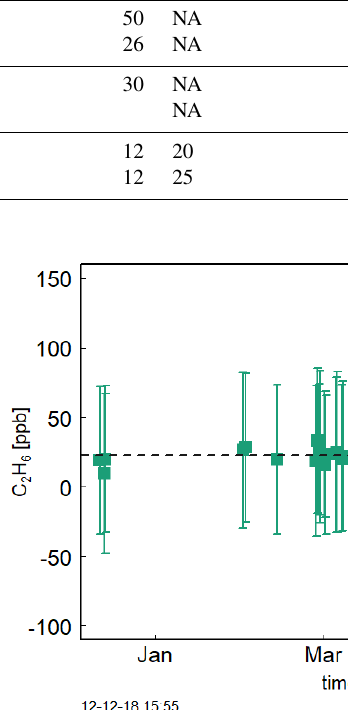
Figure 5. Measurements (20min) of Target Gas 5 over half a year. For each measurement point, squares represent averaged value and error bars − 1 standard